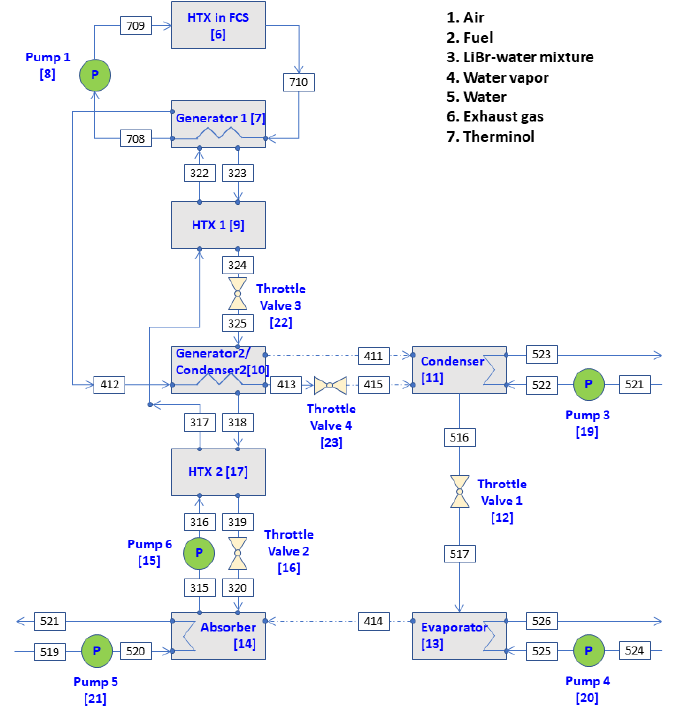
Figure 2. Schematic of industrial double-effect LiBr–water absorption refrigeration system. Energies 2022 , 15 , x FOR PEER REVIEW